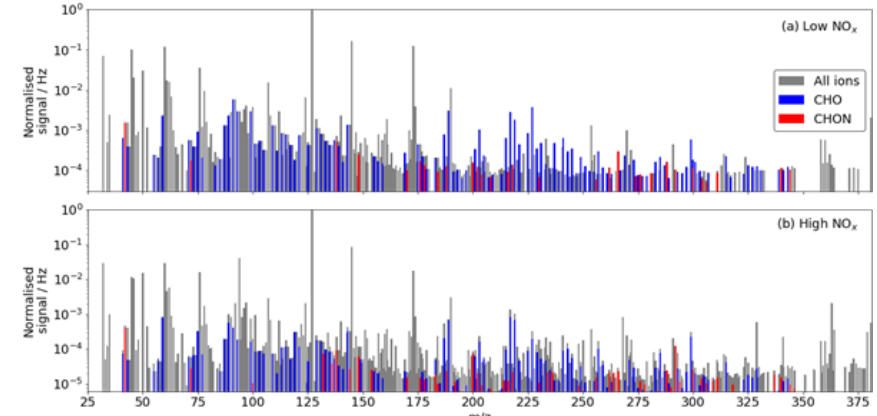
Figure 7. (a) Unit mass spectrum during benzene oxidation by OH under (a) low-NO x conditions and (b) under high-NO x conditions from the iodide CIMS. Identified CHO and CHON compounds are highlighted.